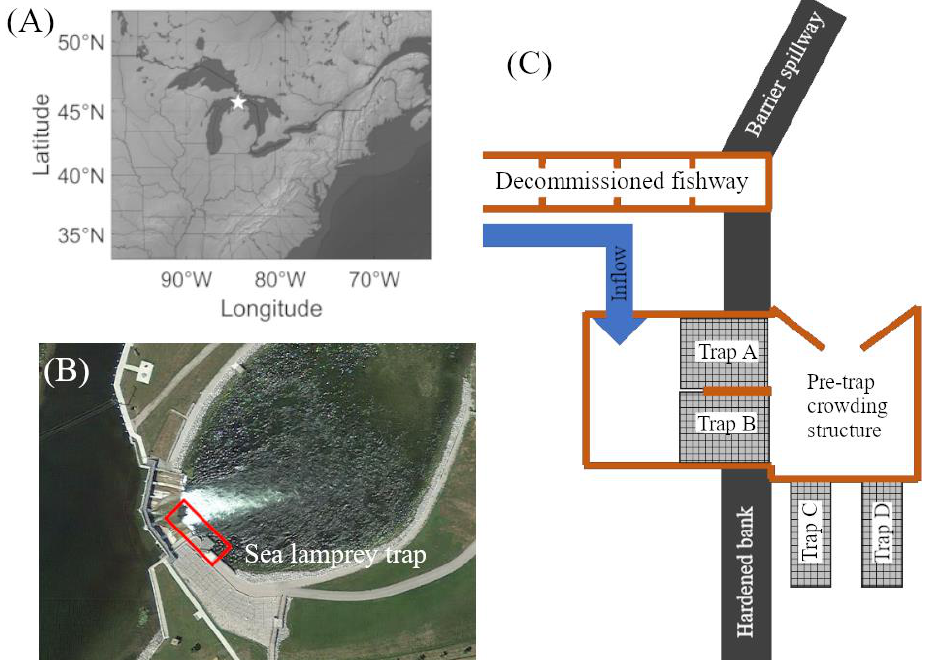
Figure 1. ( A ) Location of the Cheboygan dam (star) in the northern lower peninsula of Michigan, USA. ( B ) Cheboygan Dam and sea lamprey trap are located in the red rectangle. ( C ) sea lamprey trap depicting the pre-trap crowding structure with collection pot style traps positioned along the south (Traps A and B) and east (Traps C and D) walls, attractant water inflow, decommissioned fishway, and the barrier spillway. The ASFL was installed in Trap D.